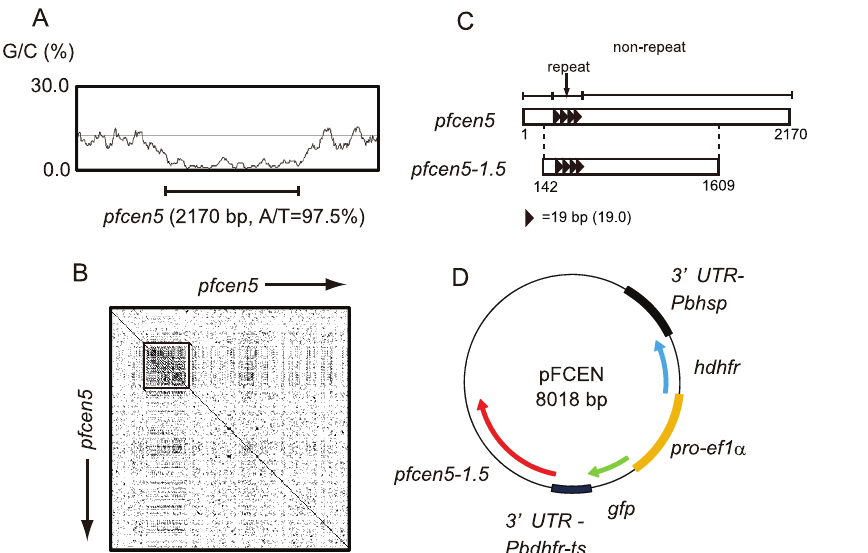
Figure 2. Sequence Properties of the Centromere from Chromosome 5 of P.falciparum and the Plasmid Map of pFCEN. (A) The sequence analysis of the centromere of chromosome 5 of P. falciparum was performed using Artemis 11 with regard to its length and A/T content. The line at the bottom indicates the centromere, and its length and A/T content are 2170 bp and 97.5%, respectively. The genomic sequence data of chromosome 5 were obtained from PlasmoDB (http://plasmodb.org/). (B) The repetitive region in the centromere of chromosome 5 was identified by the dot matrix analysis using the Dotlet program. The inset box indicates the repetitive region in this centromere. (C) The centromere of chromosome 5 is schematically shown and named pfcen5 in this Figure. The line on the top indicates the repetitive and non-repetitive regions. The triangle indicates the 19 bp of the repeat sequence motif, and the number in parentheses is the number of repeats within the repetitive region. The schematic drawing of pfcen5-1.5 also is shown. The numbers at the bottom are based on the sequence number of pfcen5 and correspond to the beginning and the end of pfcen5-1.5 . (D) The pFCEN plasmid is 8018 bp, and pfcen5-1.5 is placed downstream of the 3 9 UTR of the dhfr-ts gene of P. berghei .